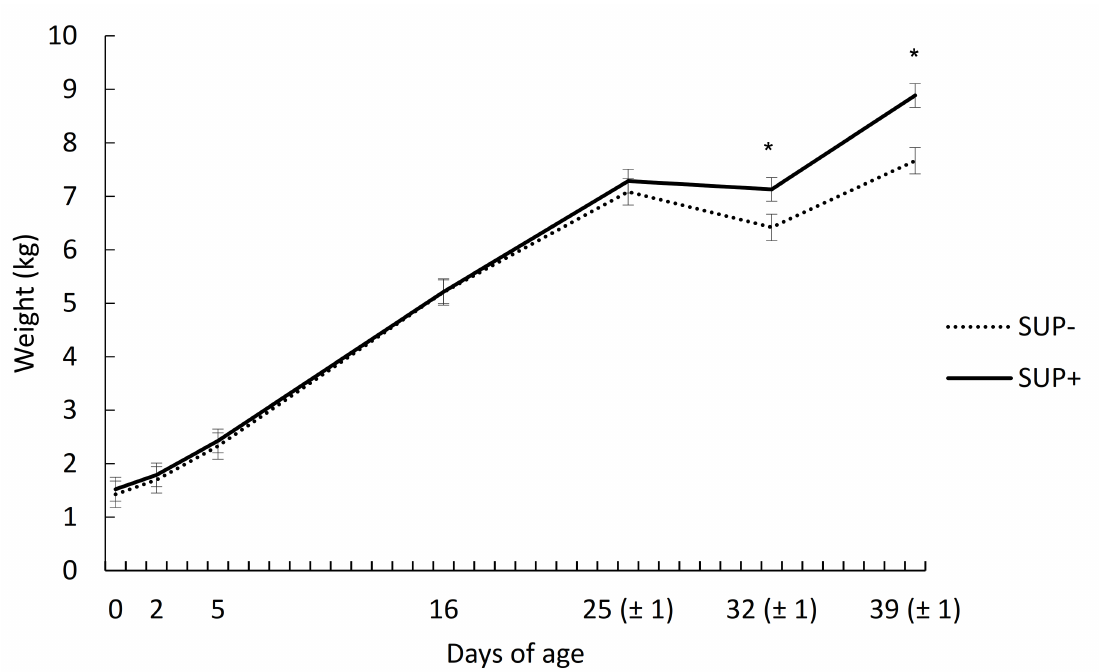
Figure 1. Development of body weight from birth to Day 39 of age of piglets from the unsupplemented (SUP − ) or supple- mented (SUP+) group. The supplement, given at birth, consisted of a mixture of probiotics, prebiotics, immunoglobulins, vitamins, and selenium. The supplementation × day interaction was p = 0.05. * indicates a difference ( p < 0.05) within a day.